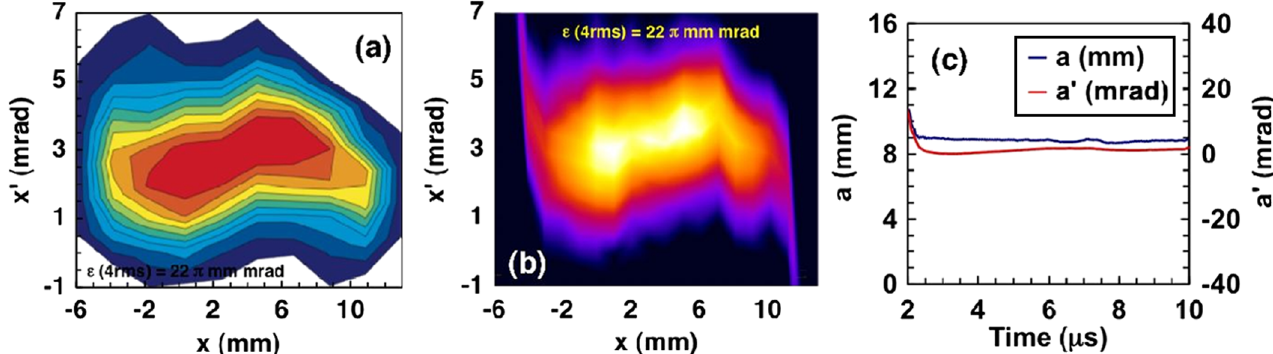
FIG. 11. (Color) Sheared phase-space distribution integrated over a 500 ns gate in the middle of the 10 (cid:1) s beam pulse: (a) measured with a double slit and a Faraday collector; (b) measured optically and; (c) beam envelope as a function of time. All were measured 40 cm downstream of the exit of two solenoids ( z (cid:6) 171 cm